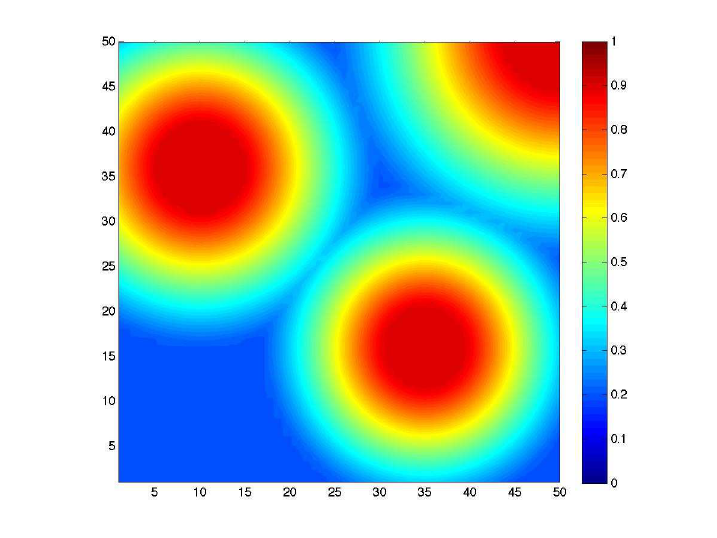
Figure 2. Area 50*50 with its desired detection probability